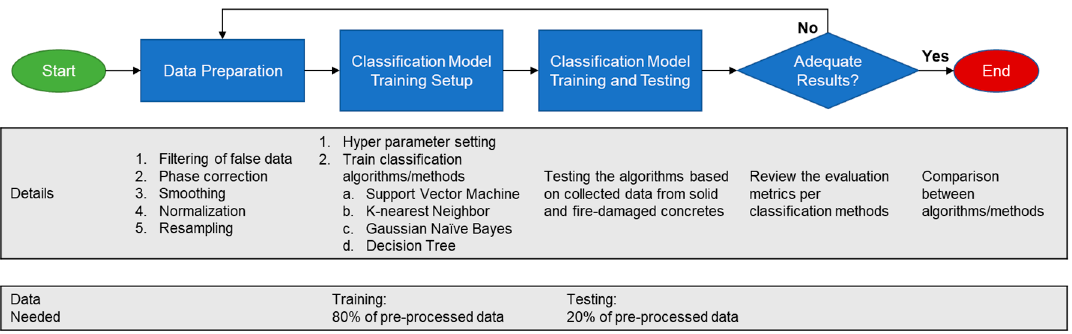
Figure 5. Frequency window for averaging magnitude squared coherence (MSC).